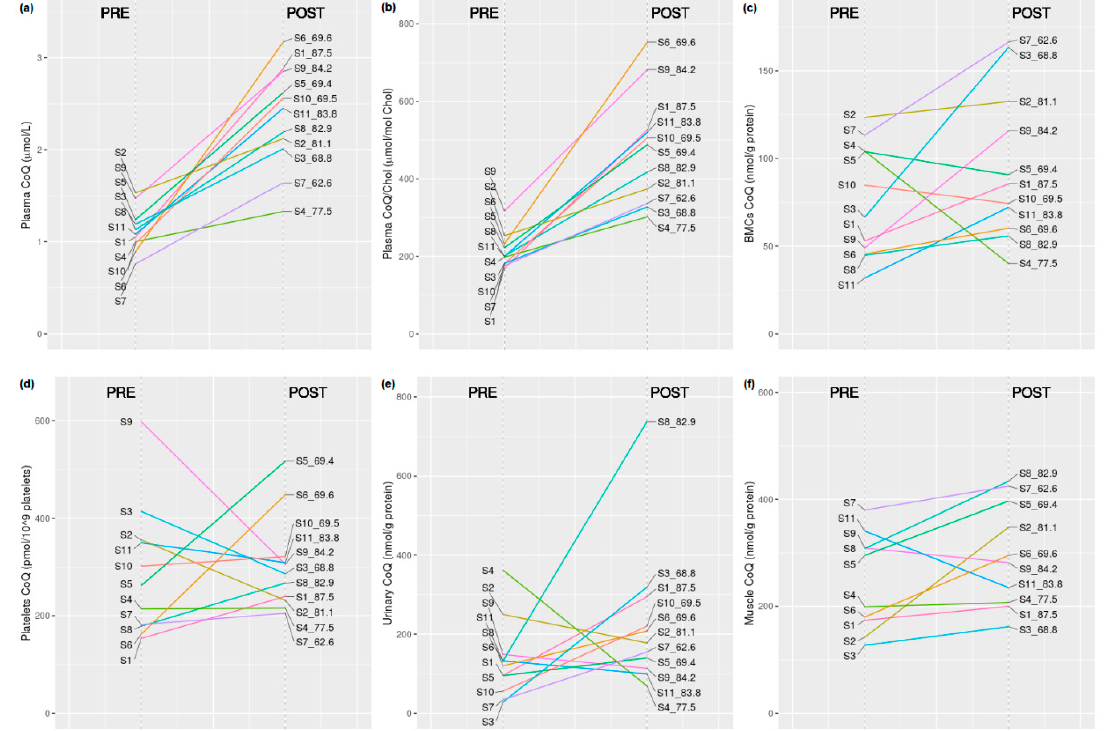
Figure 2. Graphic representation of the individual CoQ values obtained in the different biological specimens before (group 1, PRE) and after (group 2, POST) CoQ supplementation in the 11 participants: ( a ) plasma, ( b ) plasma CoQ/Chol ratio, ( c ) BMCs, ( d ) platelets, ( e ) urine, and ( f ) skeletal muscle. The body weight (kg) of each subject is indicated on the right side (POST).